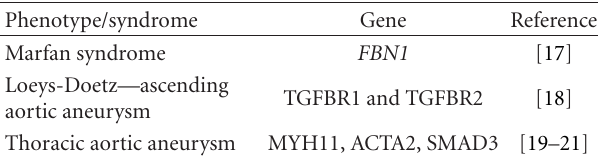
Table 1: Monogenic causes of thoracic aortic